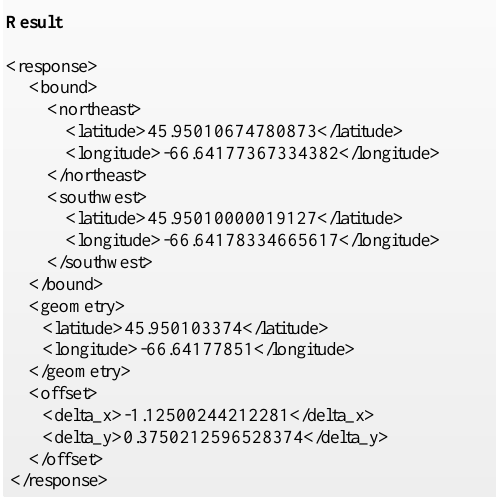
Figure 8. Forward geocoding a four-word code